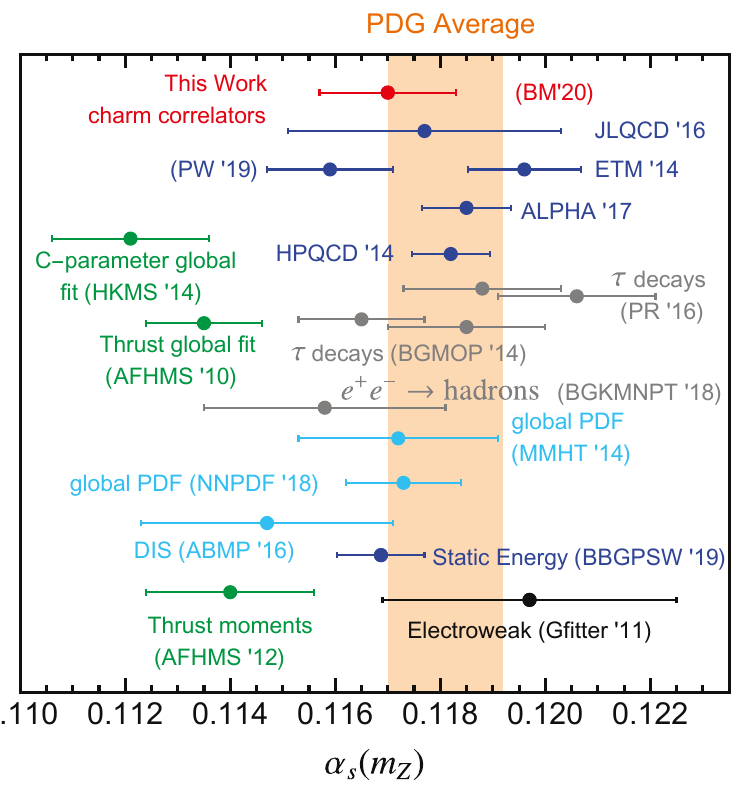
Figure 5 . Comparison of our main determination of (cid:11) ( n f =5) s ( m Z ) (red on top) with some selected determinations. Event-shape analyses at N 3 LL 0 + O ( (cid:11) 3 ): thrust and C-parameter (green) [78{80]; s lattice QCD [11, 12, 77, 81, 82] and static energy potential [83] (both use lattice input, in dark blue); electroweak precision observables (cid:12)ts [84] (black); Deep Inelastic Scattering [85] and global PDF (cid:12)ts [86, 87] (light blue); and hadronic (cid:28) decays [88, 89] and e + e (cid:0) ! hadrons [90] (gray). The current world average [47] is shown as a translucent orange